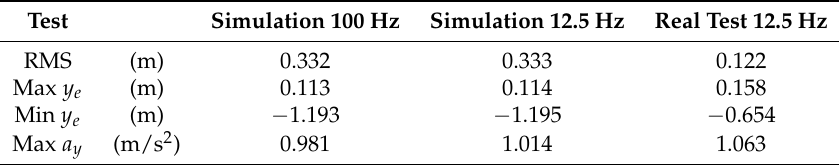
Table 7. Evaluation parameters for difference between simulation and real